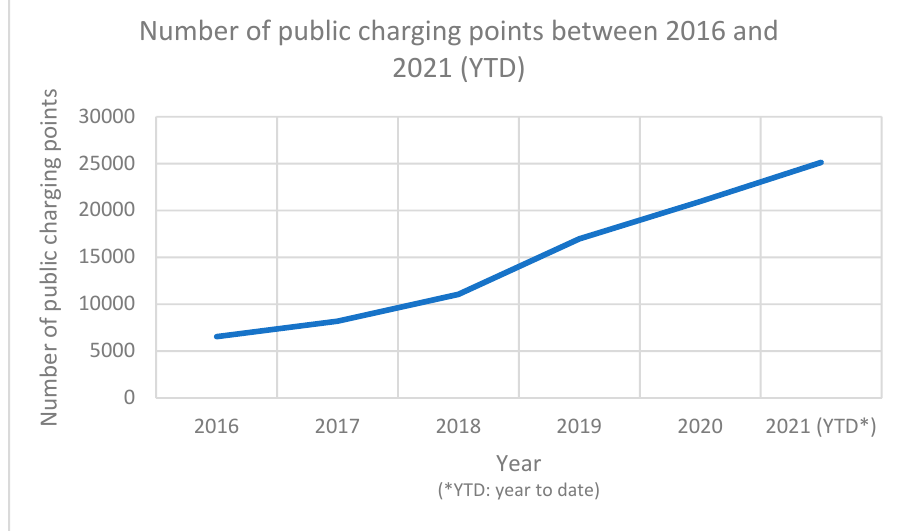
Figure 5. Chart highlighting the growth in public charging points between 2016 and 2021; data shown until the 6th of August 2021 [39].